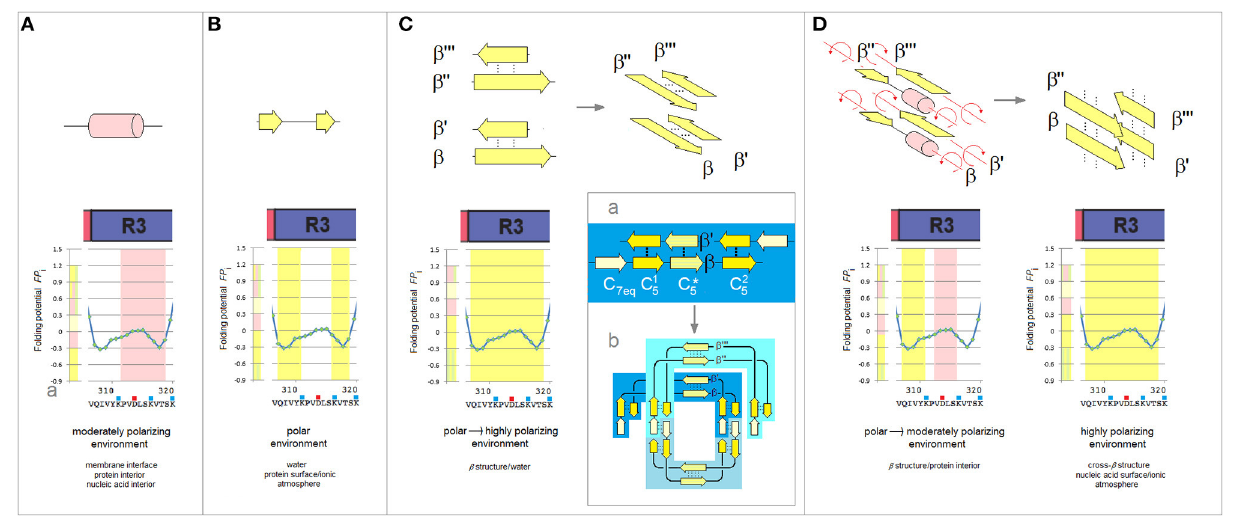
FIGURE 5 | The polarizing effect of the medium, secondary structure propensity of R3, and the mechanism of antiparallel-to-parallel β structure conversion as a path to paired helical filaments of tau. (A) The V306-K321segment of the third repeat is expected to fold into a “helix” in a moderately polarizing environment e.g., in the interior of a microtubule complex. The relation between the polarizing effect of the medium and the secondary structure propensity of the polypeptide backbone is indicated in these diagrams by the color-coded bars, cf. Figure 1B , juxtaposed with the FP i plots. (B) The V306-K321 segment is expected to remain disordered in the aqueous buffers, see text. (C) The V306-K321 segment is stabilized in water in the “C 5 strand” configuration by the formation of a two-stranded antiparallel β sheet (binding and folding “gain-of-structure”). The two antiparallel β sheets can in principle be superposed in the parallel alignment as shown in the diagram on the right; (a) The archetypal ‘productive’ homodimer of the amyloidogenic region comprises three β -sheets C 1 5 ↑ C 2 5 ↓ /C * 5 ↑ C * 5 ↓ /C 2 5 ↑ C 1 5 ↓ and is “appended” by the N-terminal “C 7eq strands”; (b) The head-to-tail aggregate of three homodimers folded into a disk-shaped paranucleus. Note the parallel alignment of the two superposed homodimers. (D) The V306-K321 segments lose the “C 5 strand” propensity and become disordered when they are placed in a poorly polarizing environment of the protein interior as a result of aggregation of the paranuclei. The antiparallel β sheets dissociate and the rotation about the strand axes yields parallel alignment of the V306-K321 segments. In the highly polarizing environment of the extended β -cross structure, cf. Figure 1B (d), these segments will again attain the “C 5 strand”